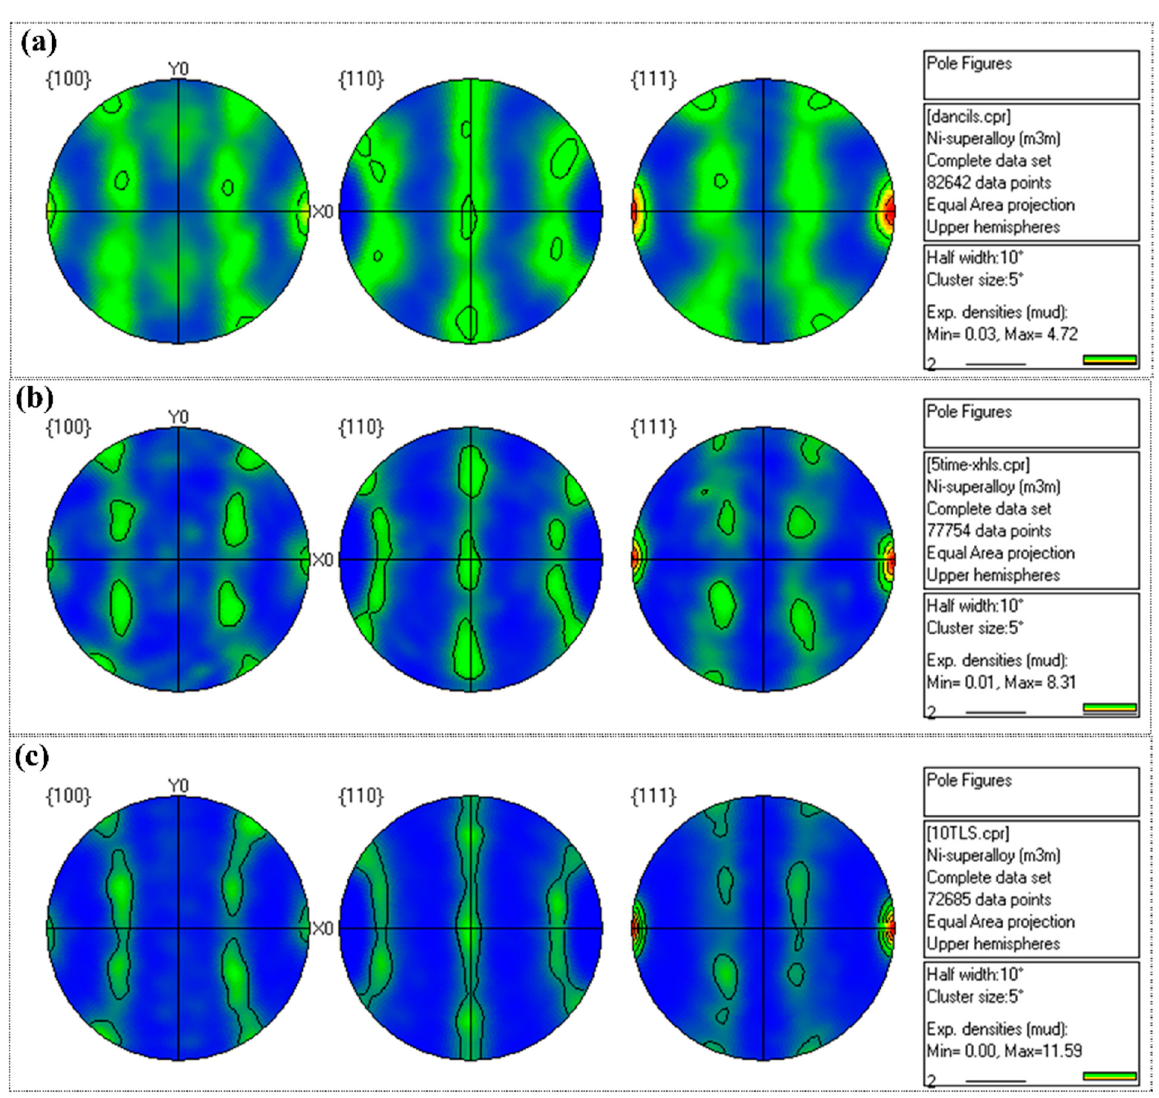
Figure 6. Pole figure from the EBSD data showing the texture intensity ( a ) Pole figure of UT, ( b ) 5-TC-UT, and ( c ) 10-TC-UT specimens.